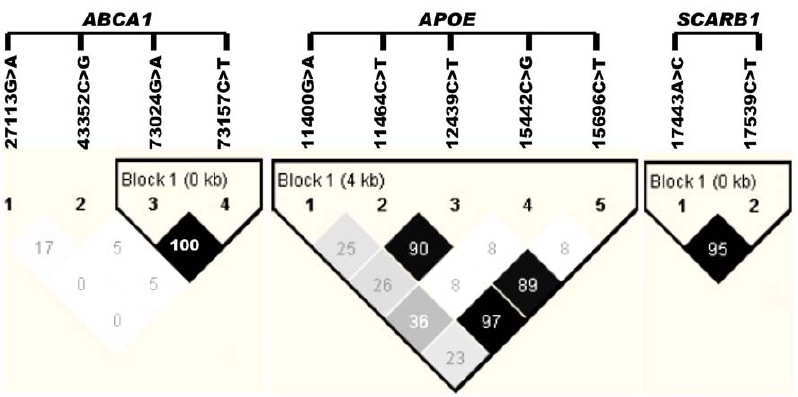
Figure 1. Linkage disequilibrium analysis for markers in the bovine ABCA1 , APOE and SCARB1 genes. Pairwise linkage disequilibrium relationship for these SNPs are based on r 2 measurements.